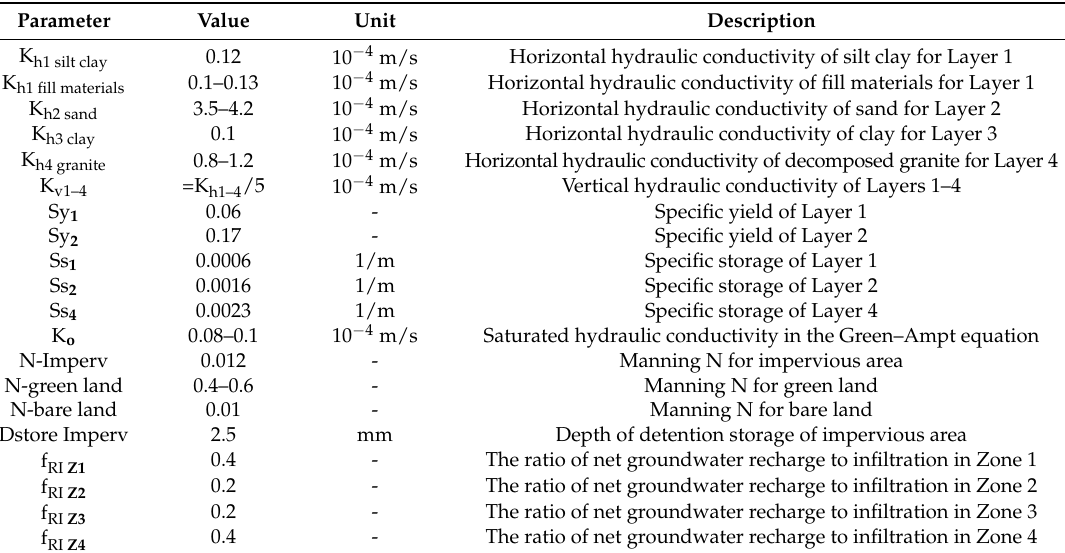
Figure 4. The divided elements and boundary condition of the Finite Element Subsurface FLOW system (FEFLOW) model. Table 1. The parameters used in the